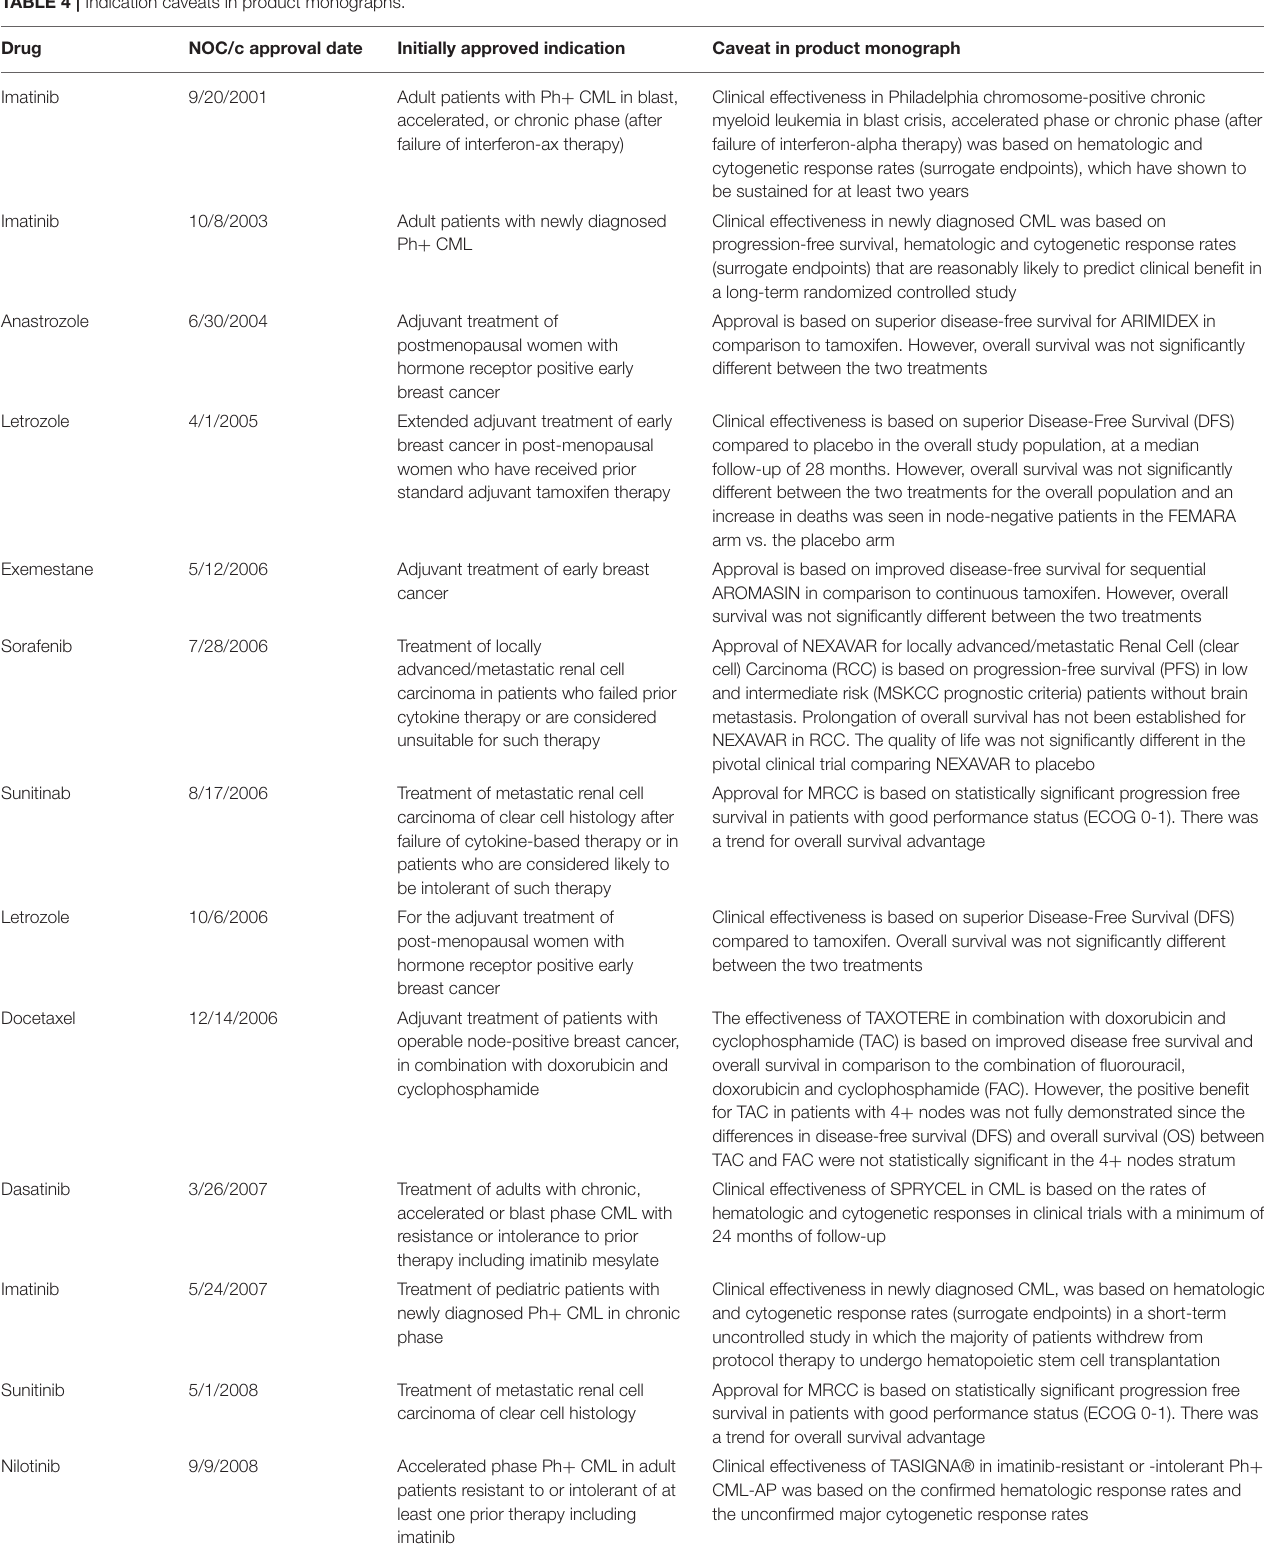
TABLE 4 | Indication caveats in product